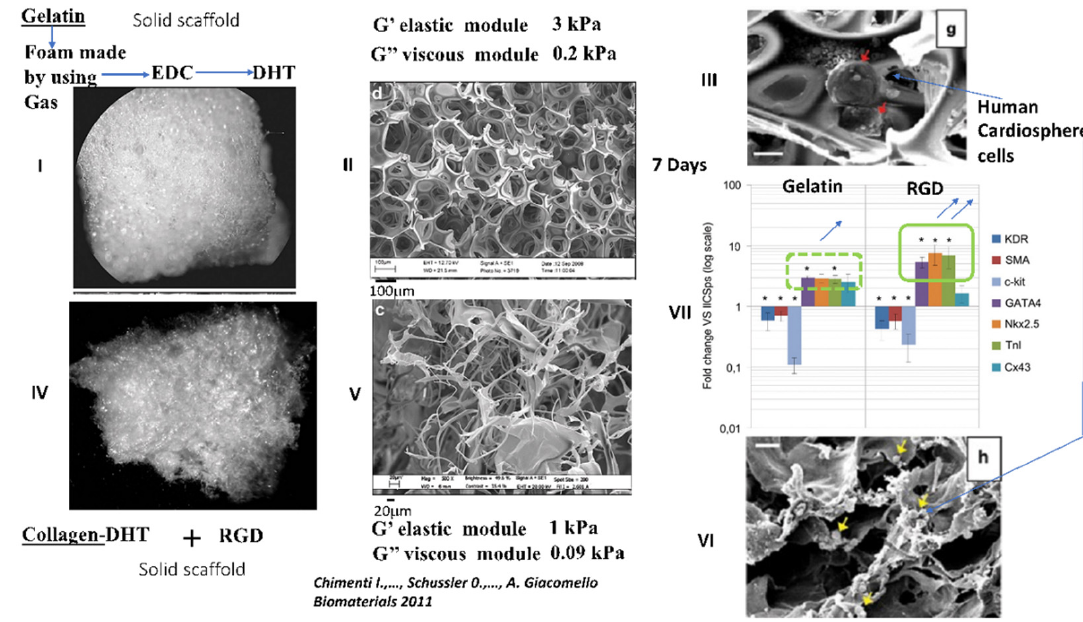
Figure 4. Comparison of the behavior and differentiation potential of “human Cardiospheres” towards cardiomyocytes in vitro, after seeding in solid DHT gelatin (panels I , II , III ) or solid collagen DHT functionalized with the RGD peptide (panels IV , V , VI ). The solid gelatin scaffold has been obtained by firstly fabricating a porous foam by insufflating gas in gelatin solution and then through chemical reticulation by EDC to maintain the architecture (as one of us has previously reported [127]). To increase the porosity of the preparation, the foam underwent further DHT procedures, as reported earlier [127] (Panel I ). The preparation has a low stiffness value of around 3 kPa (Panel II ). The solid scaffold (Panels IV , V , VI ) has been prepared using a commercial collagen scaffold obtained by DHT (i.e., Ultrafoam™ from Bard) and functionalized with the RGD peptide, as we have previously reported [48]. The stiffness of the collagen after functionalization with the RGD is around 1 kPa (Panel V ) [128]. As previously reported, and as shown in panel III , “human Cardiospheres” in a solid gelatin scaffold stay as a cluster, while in solid collagen RGD, the structure “as cluster” is lost and the cells migrate through all the scaffold. Cardiomyocyte markers, GATA4, Nkx2.5 and troponin, are 3 times higher in collagen RGD than in gelatin-based scaffolds. Thus, for engineering a contractile tissue, the collagen RGD preparation seems to be better than that with gelatin